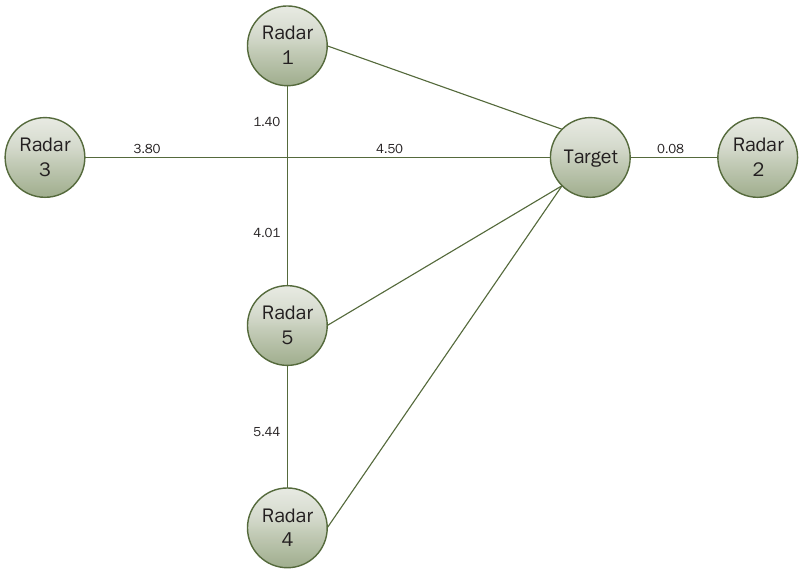
Figure 7. Relative position of five radars with the target when the target moves along a straight line.